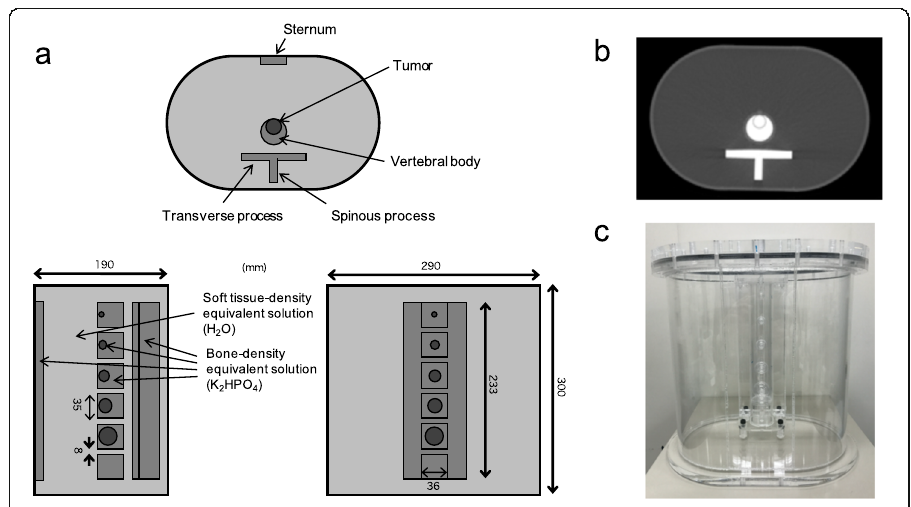
Fig. 1 Custom-made thoracic spine phantom. Simplified schema ( a ), CT image ( b ), and photograph ( c ) of phantom. Example of setup shows vertebral body phantoms with tumors of 10, 13, 17, 22, and 28 mm in diameter. Vertebral body phantom without tumors is at the bottle. Vertebral body, tumor, processus, and sternum contain K 2 HPO 4 solution with density equivalent to that of bone and 18 F-NaF. Elliptical body phantom contained 18